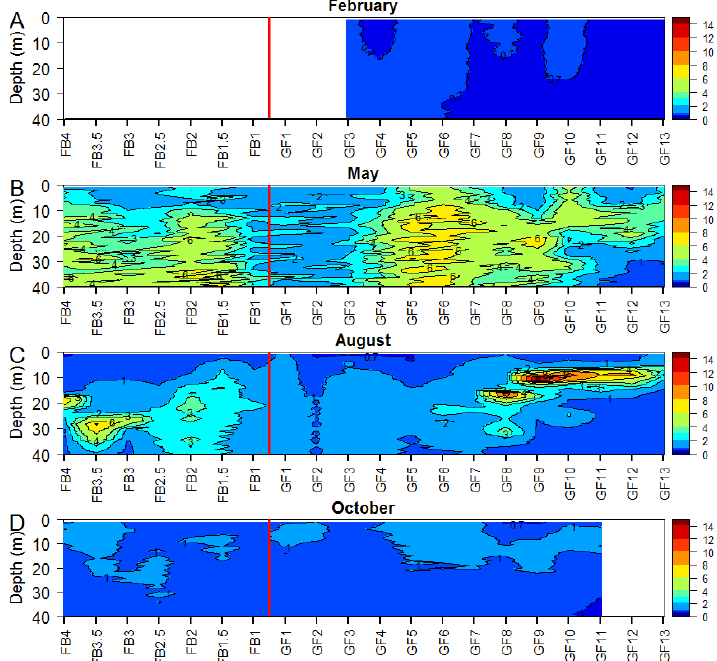
Figure 4. Transects of fluorescence (calibrated vs. chlorophyll a in µg L − 1 ) from the shelf area (left) to glaciers (right) during February (a) , May (b) , August (c) and October (d) 2013. The red line indicates the mouth of the Godthåbsfjord